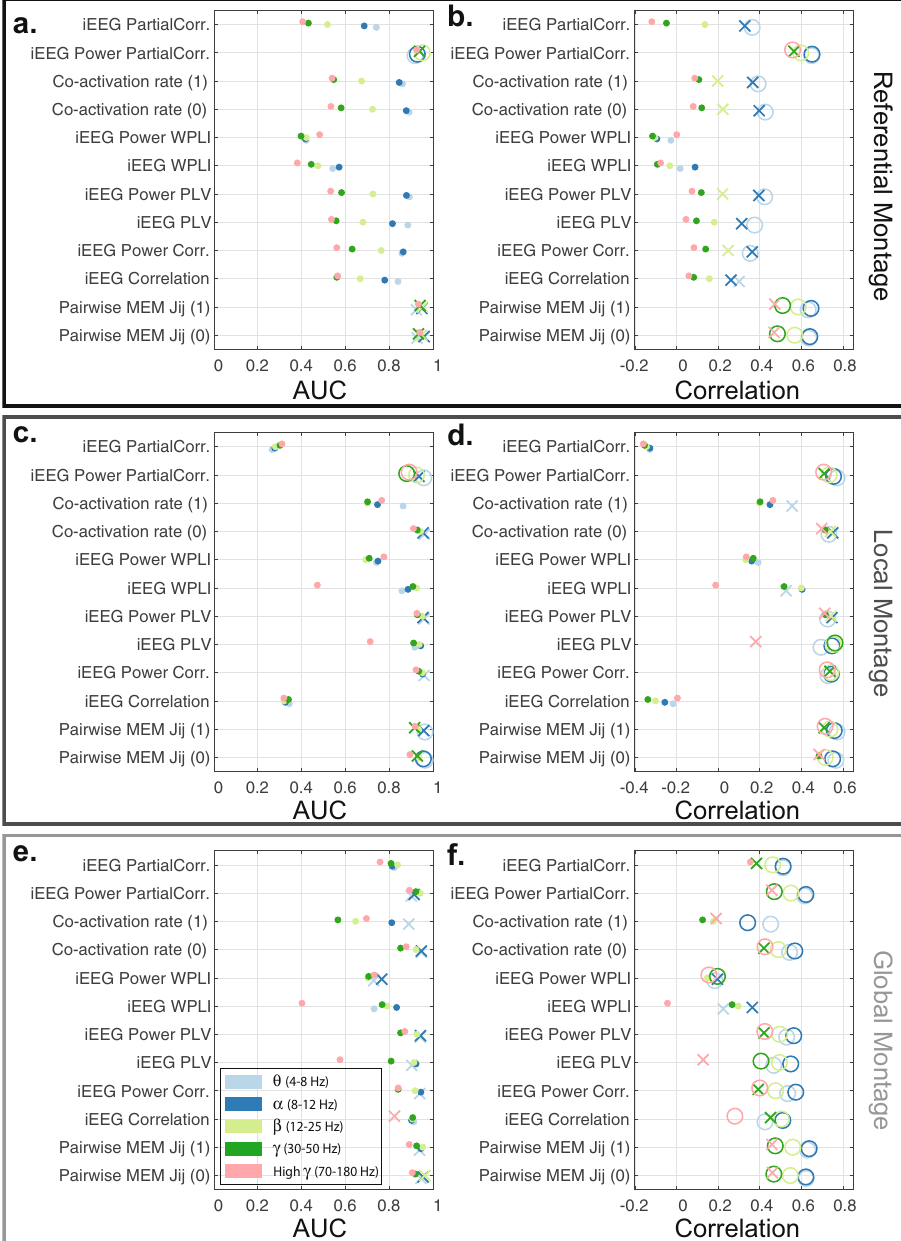
Fig. 6 Similarity between structural (log normalized streamline count) and functional connectivity estimates. The detection accuracy (measure via AUC) of structural connectivity between brain regions using several functional connectivity estimation methods, or a representative patient (#5) using three recording montages -- referential (a) , local multiple linear regression (c) , and global mean signal regression (e) montages. b, d, f The structure- function coupling, measured as the correlation between structural and functional connectivity weights of sampled brain regions for the same patient and three recording montages. Functional connectivity estimates based on the pairwise MEM and co-activation rates were calculated from binarized ( ‘ 0 ’ and ‘ 1 ’ ) power amplitude states. The remaining functional connectivity estimates (Pearson correlation, partial correlation, PLV, and WPLI) were derived from the band-passed iEEG and band-passed iEEG power time series. The results for different frequency bands are color-coded based on the legend in panel e . The AUC and correlation values signi fi cantly higher than those of geometric structural nulls (one-sided permutation test, n = 10, 000, p < 0.05) are depicted as ‘ X ’ , and values signi fi cant after FDR correction for multiple comparisons across frequency bands are depicted as ‘ O ’ Calculating predicted ’ probabilities usually is very dif fi cult in empirical and the estimated probabilities of all empirically high-dimensional datasets as calculating the normalization observed states at θ , β , and high γ frequency bands from a constant in the Boltzmann distribution (i.e., partition function) representative patient (#5) using local recording montage involves summing over all possible states. Therefore, we binarized at 1. These results show that the pairwise MEM approximate the partition function using the empirical prob- predicts the probabilities of the most frequently observed states ability of the silent state (i.e., ‘ all-off ’ ) – see 33,39 for more details. with high accuracy. Similar results are also found in all fi ve Scatter plots in Fig. 7 show the high similarity between the patients, as seen in Supplementary Fig. 15.